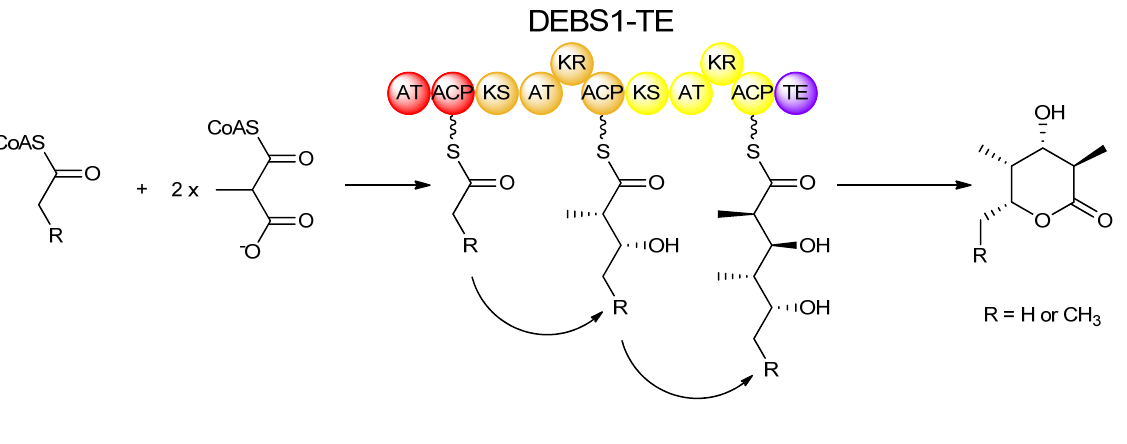
Figure 5. Synthesis of a triketide lactone by DEBS1-TE, a recombinant PKS engineered by fusing the TE domain of DEBS3 to the C-terminus of the DEBS1 protein